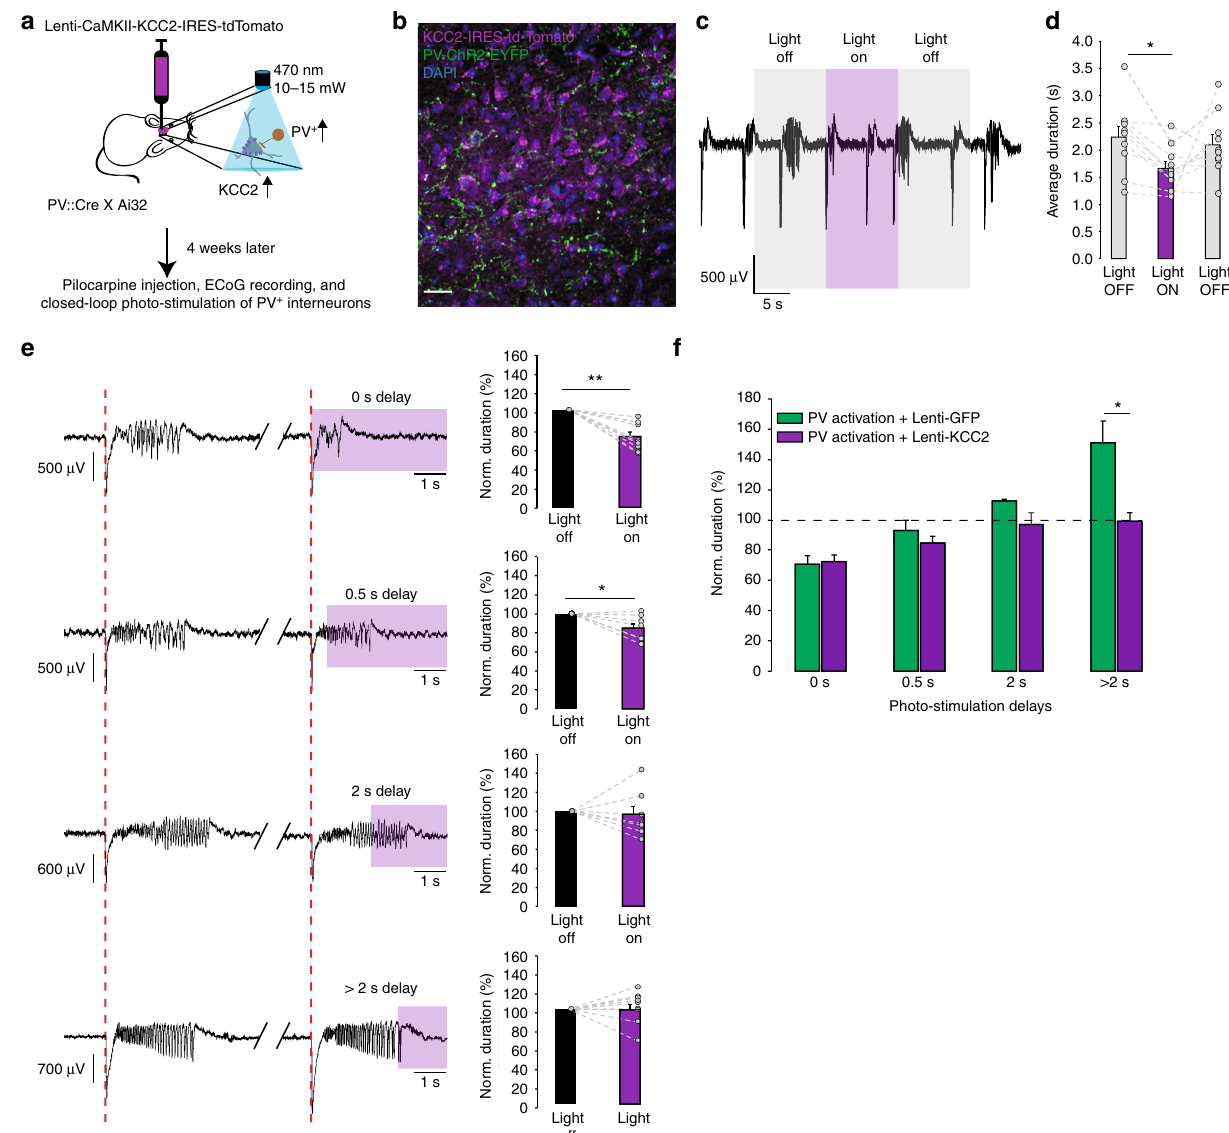
Fig. 5 KCC2 overexpression in principal neurons prevents the pro-ictal action of PV + photoactivation during seizures. a Experimental schematic. b Immuno fl uorescence of the PV-ChR2-EYFP (green), the nuclei staining, DAPI (blue), and the KCC2-IRES-tdTomato (magenta) in an overlaid image. Scale bar 25 µ m. c ECoG recordings of ictal discharges before, during and after photoactivation of ChR2-expressing PV + interneurons in animals that overexpress KCC2 in the cortical principal neurons at the site of pilocarpine injection. d Average duration of ictal discharges during the 10 s baseline (grey) and photostimulation (purple) periods. KCC2 overexpression does not affect the reduction of seizure duration by PV + photoactivation (c.f. Fig. 2; n = 8 mice, one-way repeated measures ANOVA post hoc Bonferroni correction, * p < 0.05, error bars represent the s.e.m.). e KCC2 overexpression abolishes prolongation of seizures by delayed (>2 s) PV + photoactivation ( n = 10, 7, 7 and 8 mice for the delays of 0, 0.5, 2 and >2 s, paired t -test). Sample traces illustrate pairs of consecutive seizures without and with photostimulation (intervening periods between seizures are omitted; purple rectangles indicate photostimulation). f Normalised duration of ictal discharges by photostimulation of PV + neurons in mice with (purple) KCC2 overexpression or GFP expression (green). Note that KCC2 overexpression has no signi fi cant effect on the seizure suppression when photostimulation of PV + interneurons is delivered immediately upon seizure detection. * p < 0.05, ** p < 0.01, *** p < 0.001; error bars represent s.e.m. Source data are provided as a Source Data fi